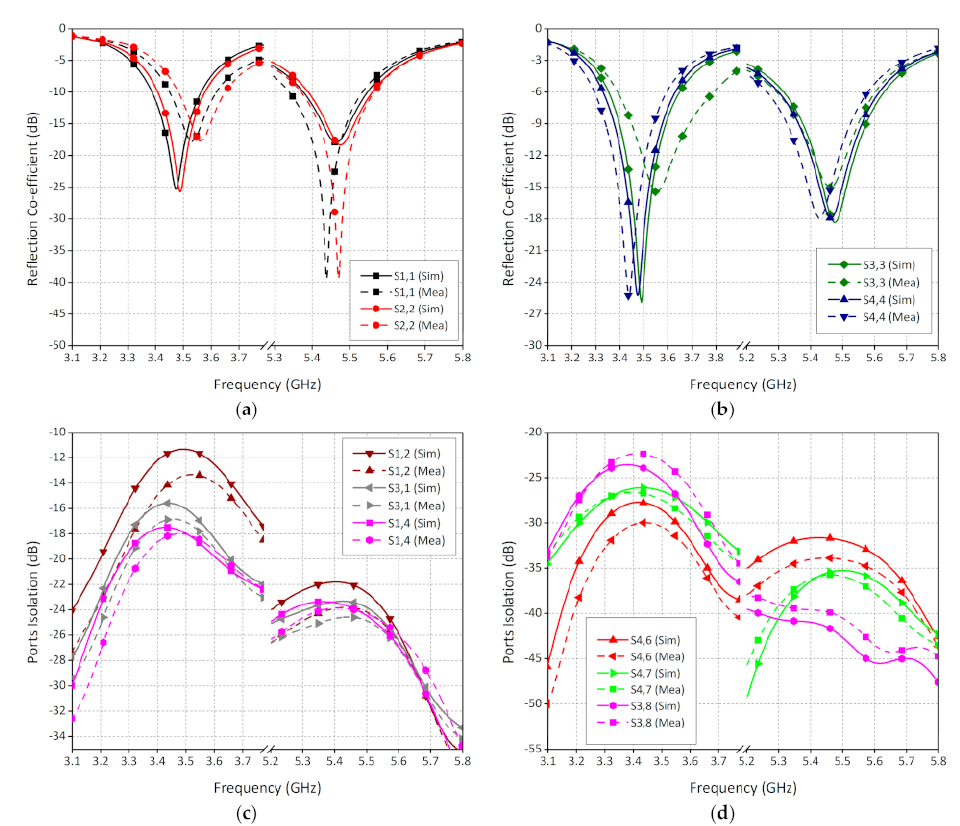
Figure 6. Measured S-Parameters of Ant1 Ant2 Ant3 Ant4. ( a ) Reflection Coefficient Ant 1 and Ant 2 ( b ) Reflection Coefficient Ant 3 and Ant 4 ( c ) Selected Ports Isolation Ant 1 ( d ) Selected Ports Isolation Ant 4 Ant